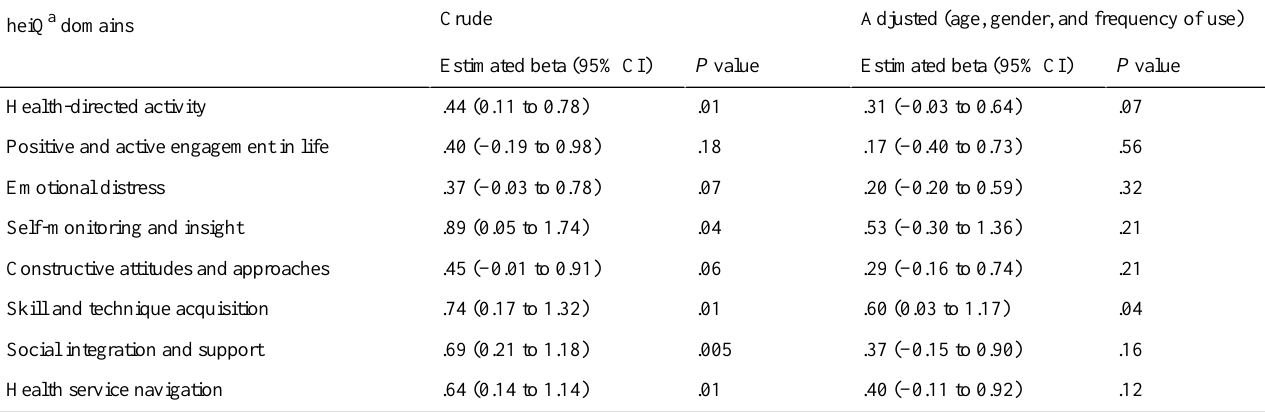
Table 3. Linear regression and crude and adjusted values (adjusted for age, gender, and frequency of use), dependent variable perceived benefit (Service User Technology Acceptability